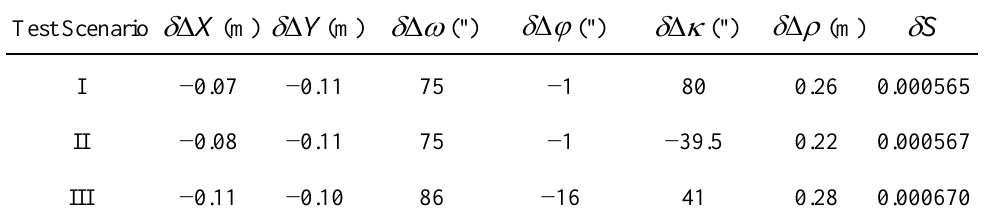
Table 4. Estimated system biases using the Simplified method for the 3 test scenarios in Table 2.